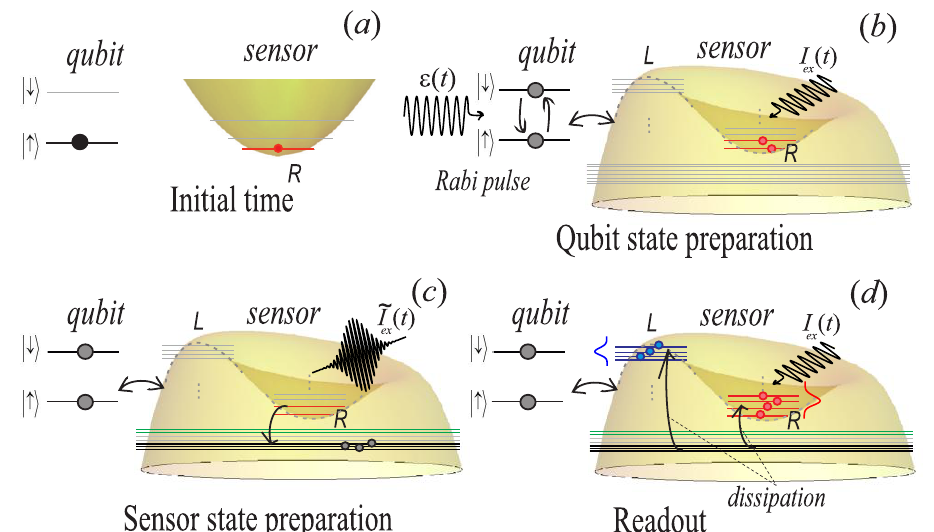
Figure 4. Schematic representation of the measurement procedure. ( a ) Initially, we assume that the qubit and the sensor are in the ground state. There is no bifurcation behavior of the sensor because no control current is applied to it. ( b ) The qubit is initialized by a Rabi pulse. There is back action on the sensor due to the coupling. The sensor control current is on. ( c ) The sensor is excited to the levels corresponding to the region outside the lobes of the classical separatrix by an additional pulsed current. ( d ) The sensor relaxes into a superposition of levels corresponding to the right and left equilibrium points. The corresponding probabilities depend on the qubit